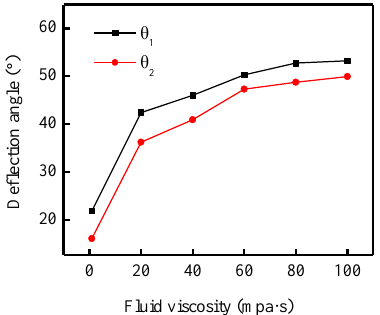
Figure 14. Relationship between fluid viscosity and two deflection angles ( θ 1 and θ 2 corresponding to quarter-length (10 m) and the half-length (20 m) deflection angle, respectively).